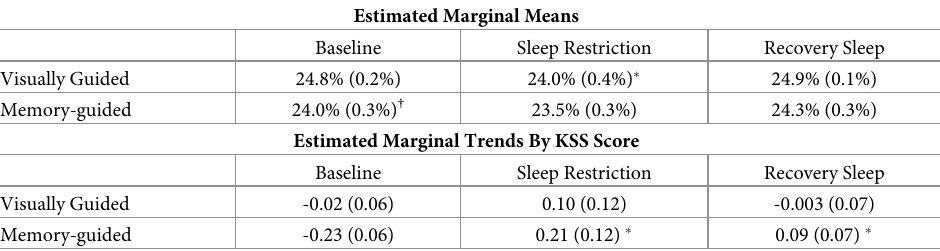
Table 3. Estimated marginal means and estimated marginal trends for force (%